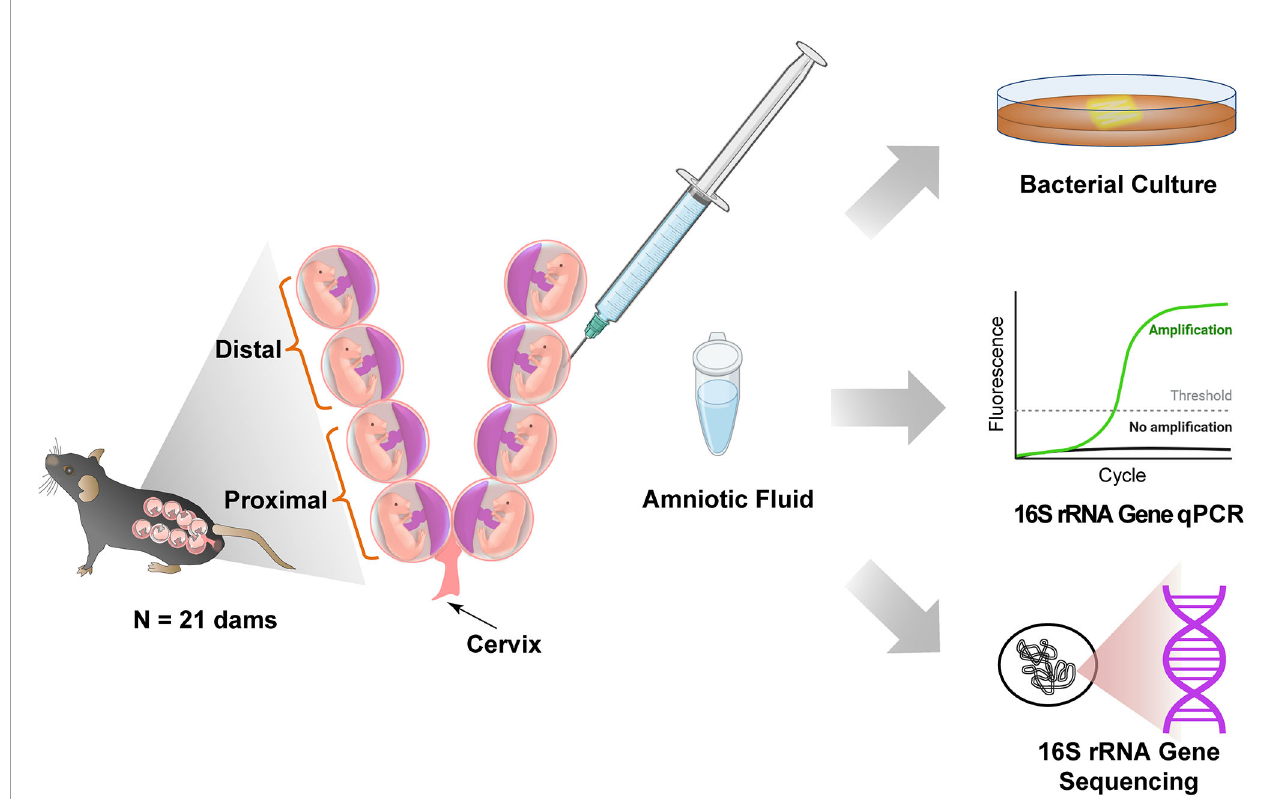
FIGURE 1 | Study design to test for the presence of bacteria in murine amniotic fl uid. Created with